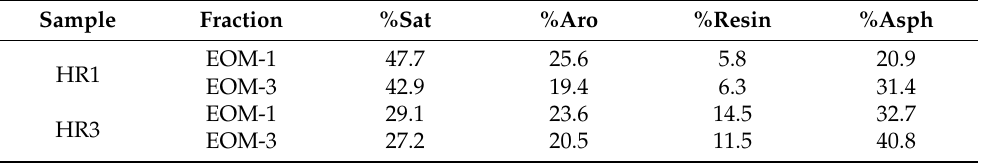
Table 2. SARA compositions of representative samples from sequential